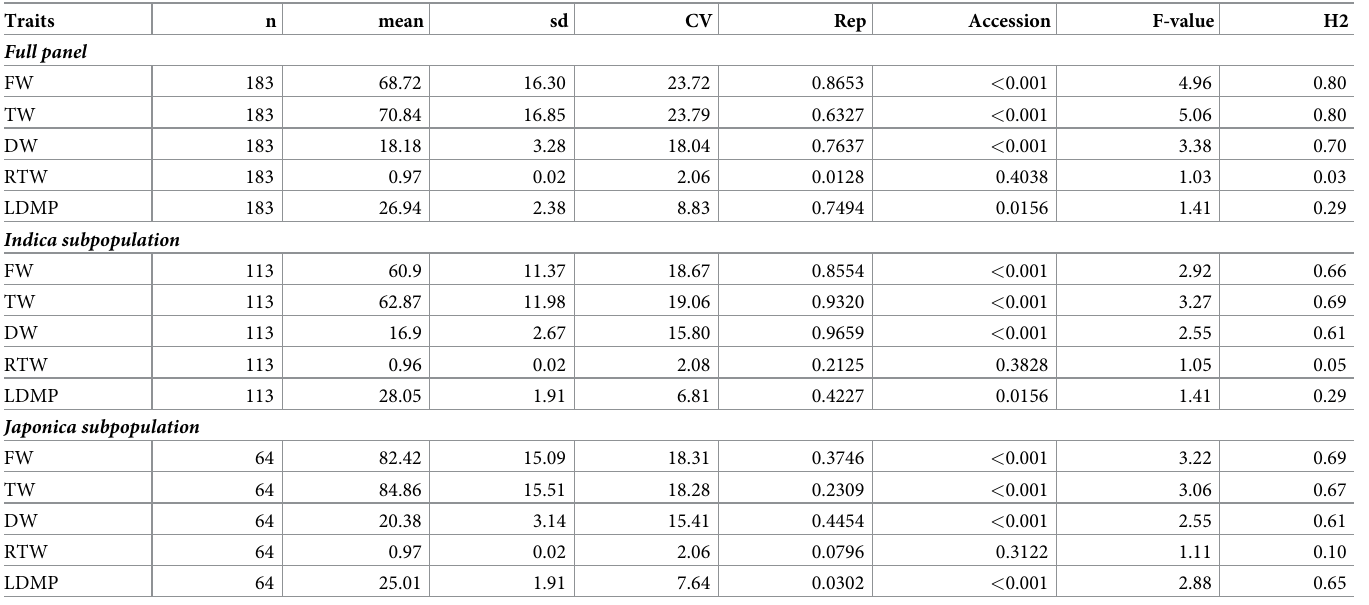
Table 1. Phenotypic variation and trait broad-sense heritability for the three